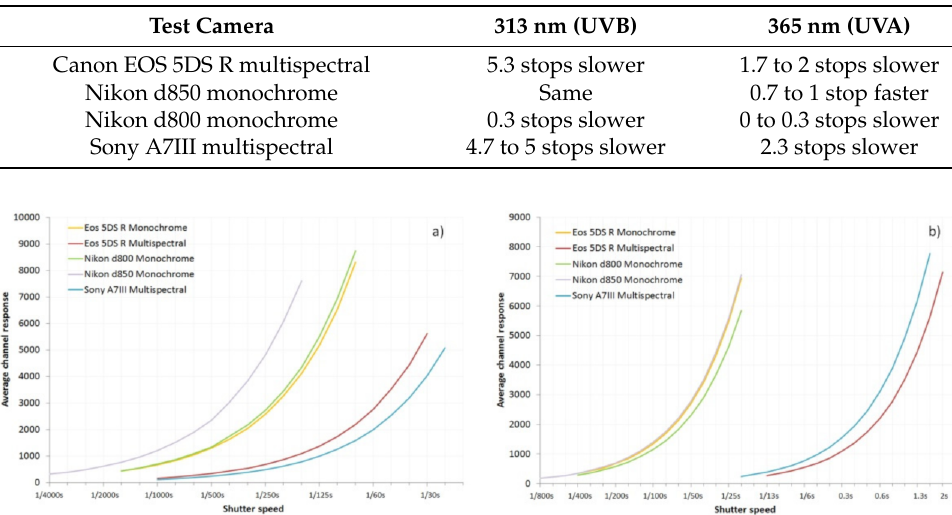
Figure 4. Average camera channel responses at ( a ) 365 nm and ( b ) 313 nm plotted as a function of exposure time (shutter speed).